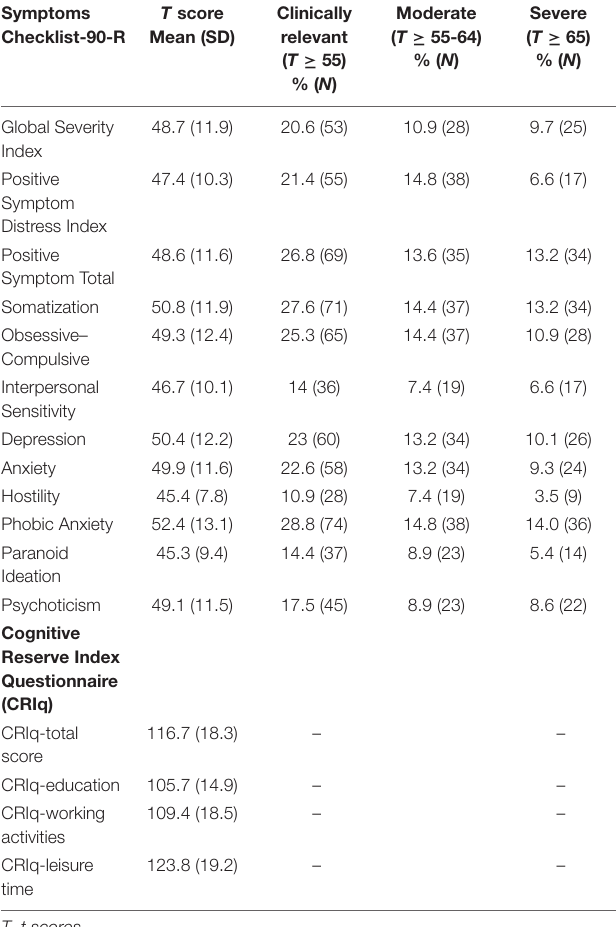
TABLE 3 | Results of the regression analysis showing that SCL-90-R primary symptoms dimensions are predicted by subjective cognitive